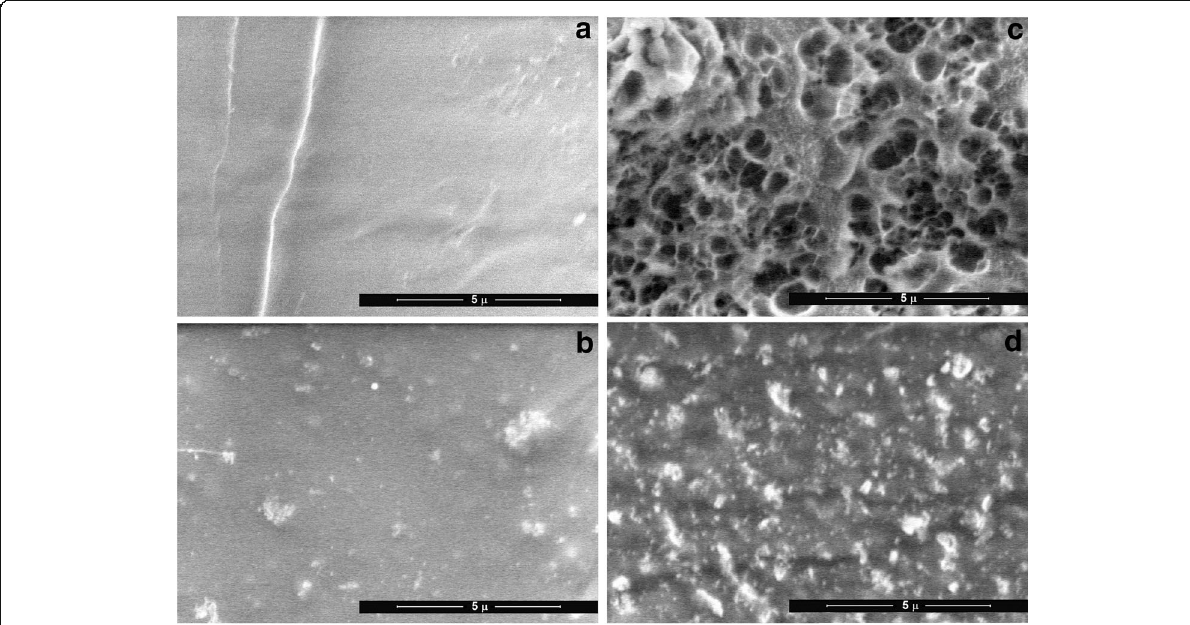
Fig. 2 LVSEM of samples after freeze-drying: PHEMA (No 10) ( a ); PHEMA/5% nanosilica (No 11) ( b ); PHEMA synthesized in the presence of water